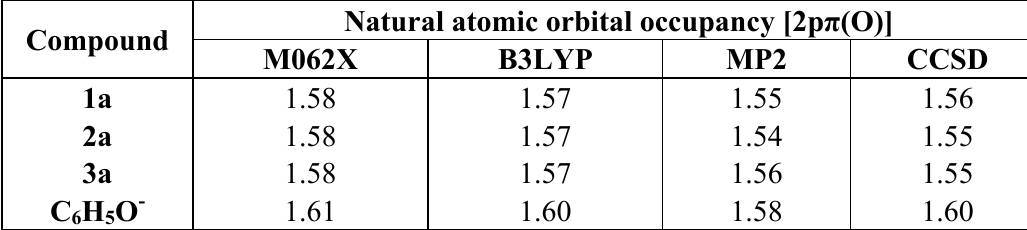
Table 3. The natural atomic orbital occupancy of the 2p  atomic orbital of the oxygen atom of silaphenolates 1a–3a and the parent all-carbon phenolate a